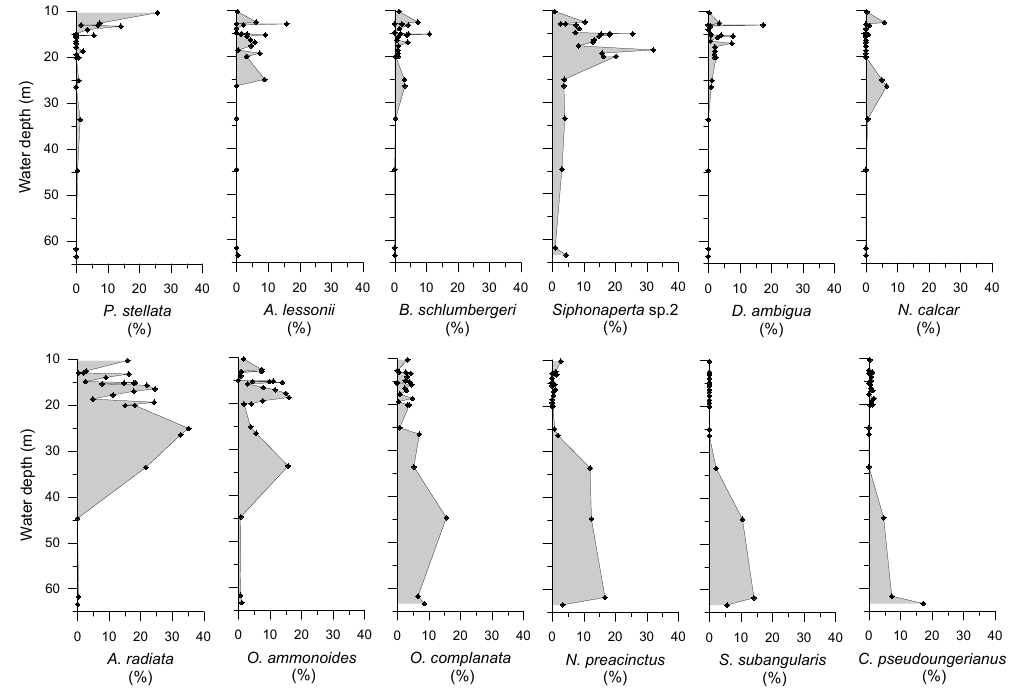
Fig. 3. Relative abundance of selected recent benthic foraminifera from surface sediments versus water depth, showing a distinct bathymetric zonation. Only species having a relative abundance of > 5% on the recent assemblages are presented. Table 3. Results of the redundancy analysis